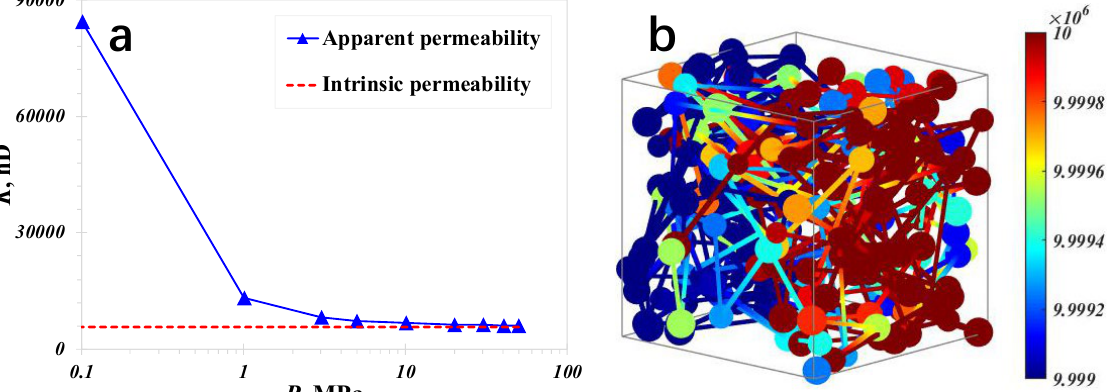
Figure 3. Apparent gas permeability under the specified pressure condition ( a ): Gas flow capacity; ( b ): Spatial pressure distribution feature.